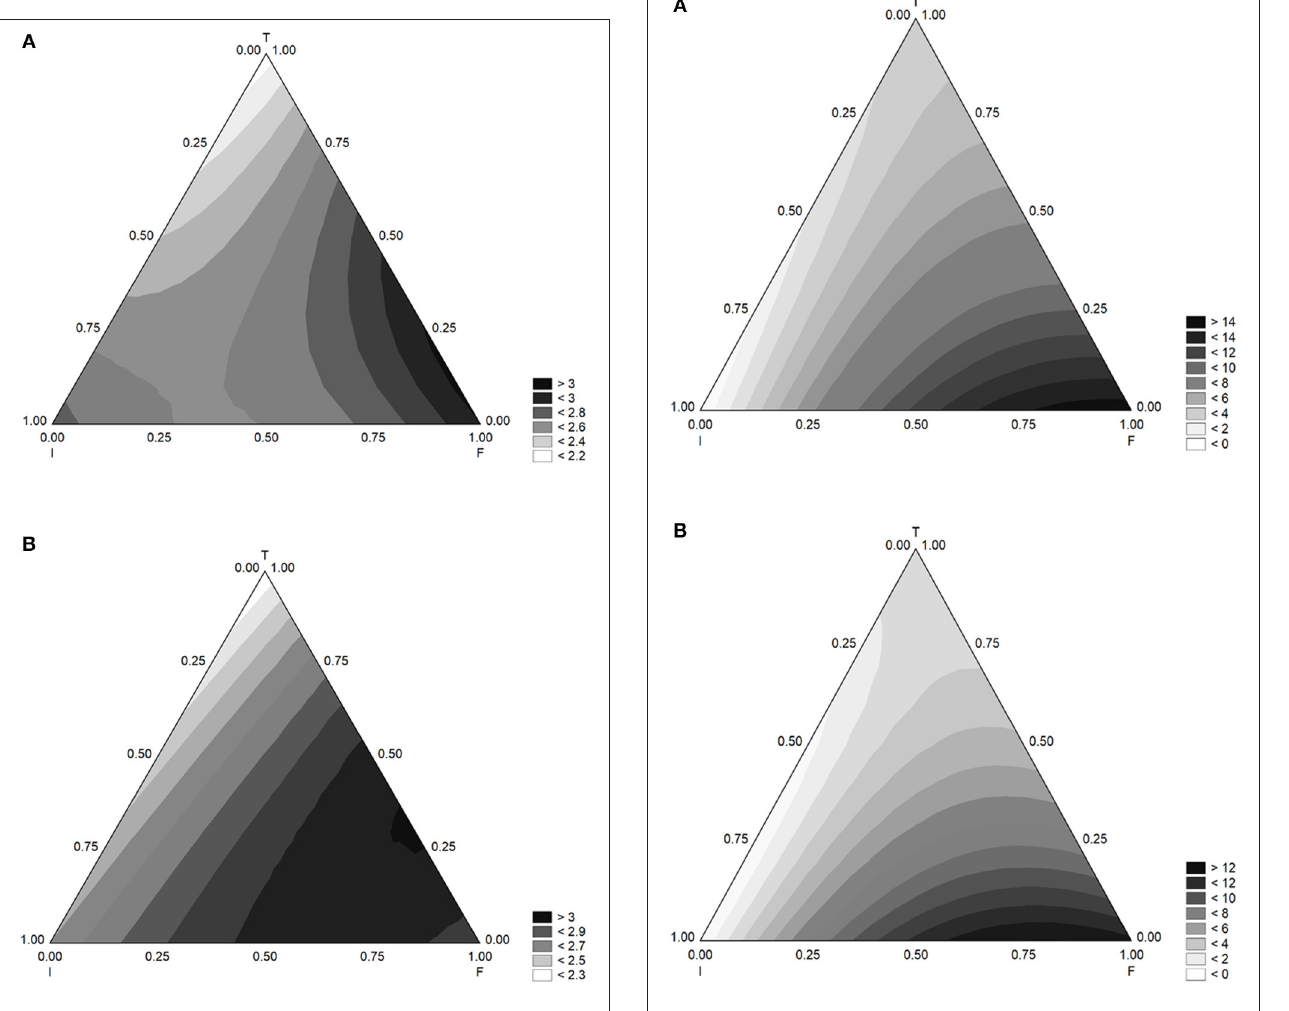
FIGURE 3 | Triangular surfaces for the effect of flour (F), inoculum (I), and temperature (T) on the acidification (parameter 1 pH max ) of L. delbrueckii subsp. bulgaricus . (A) Gluten Friendly Flour; (B) Control Flour.